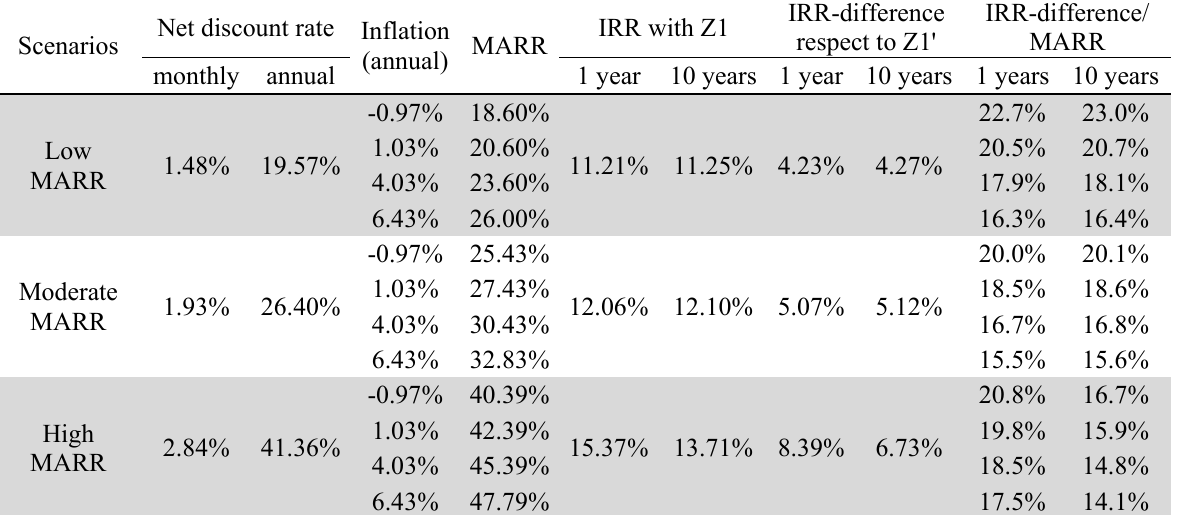
The summary of the results for different scenarios